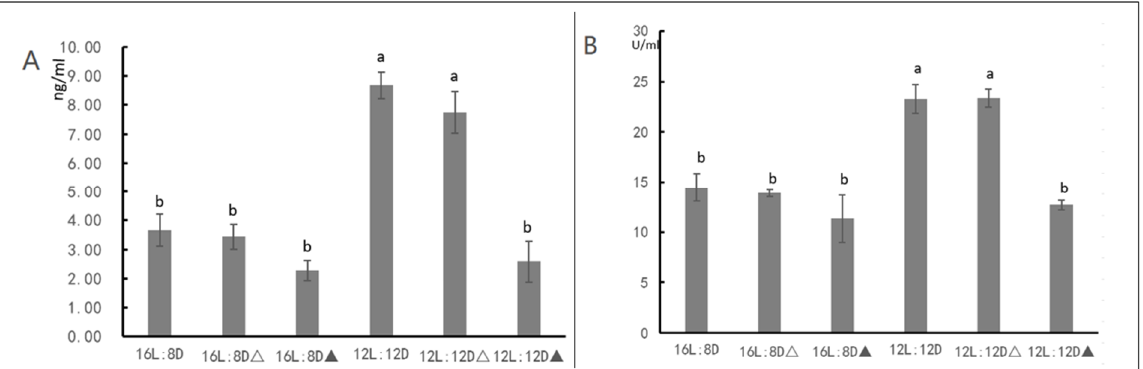
Figure 10. ( A ) HDAC enzyme activity after HDAC inhibitor injection under different light conditions. ( B ) JH content after HDAC inhibitor injection under different light conditions. “ △ ” indicates that an equal amount of distilled water was injected to the beet webworm, “ ▲ ” indicates that HDAC inhibitor was injected. Different letters represent significant differences.